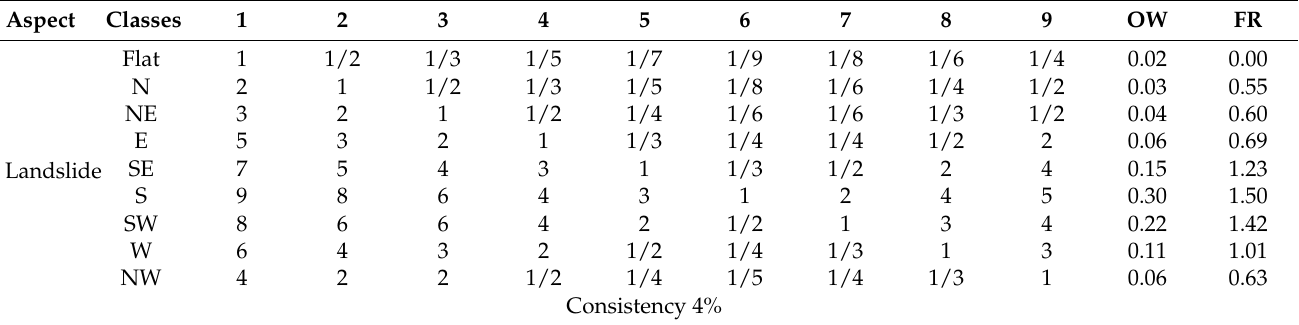
Table 7. AHP matrices and OWs for the aspect causative factor classes.